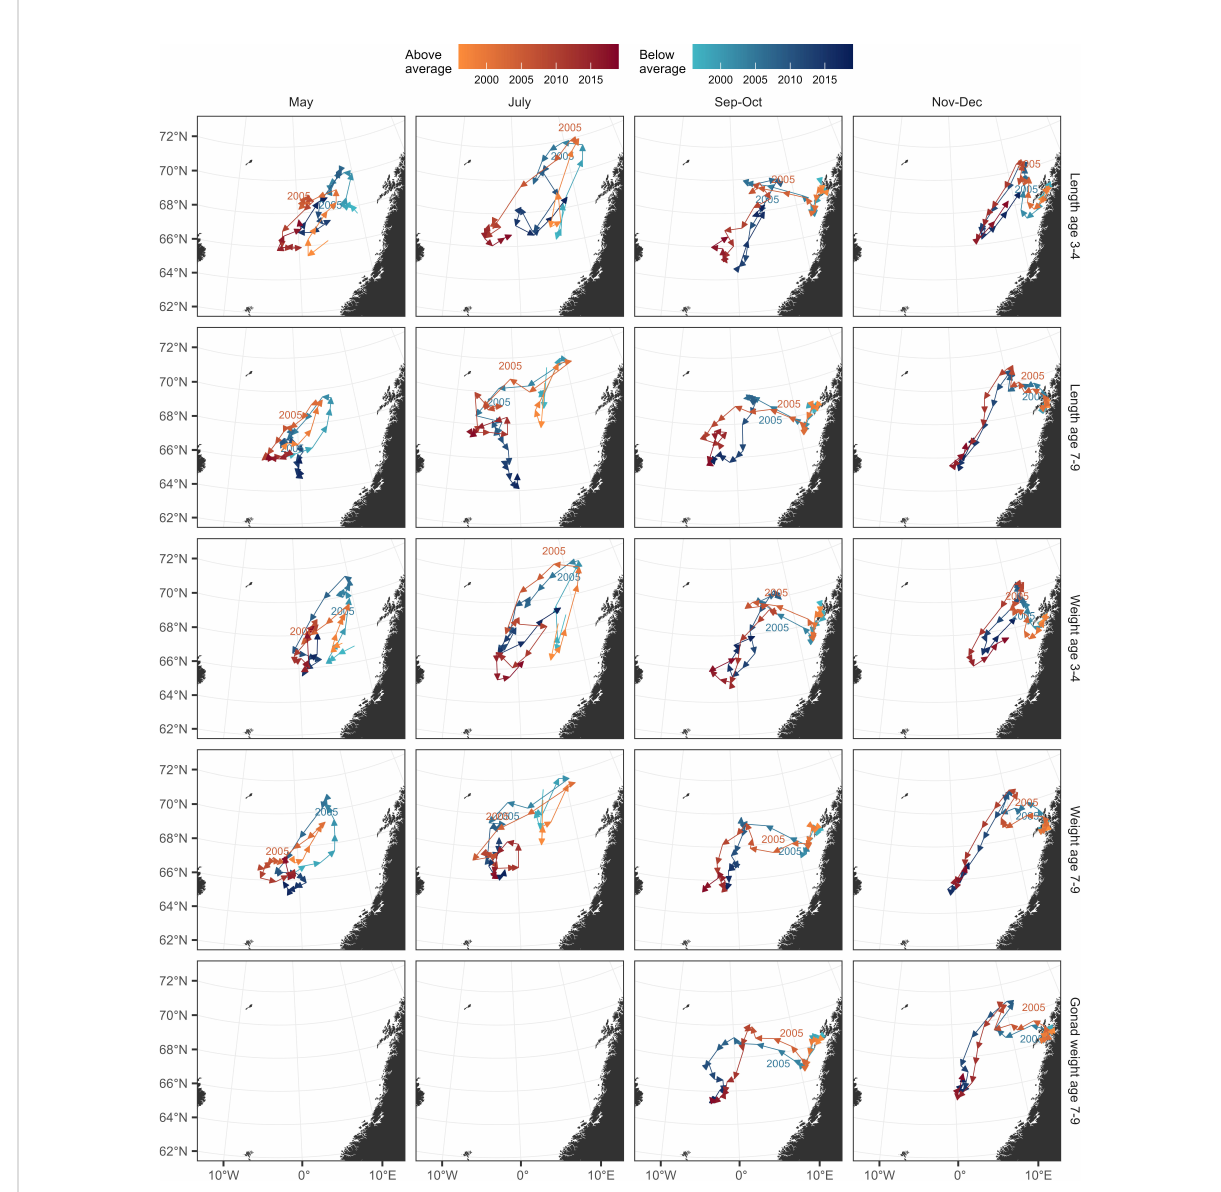
FIGURE 7 Modelled spatiotemporal changes in centre of gravity (CG) for ages 3-4 and 7-9 for length, weight and gonad weight (horizontally) and season (vertically). The variations in CG are shown split between two groups of herring having body length, fi sh weight and gonad weight either above (red) or below (blue) average. For detailed depictions including all ages, see Figures